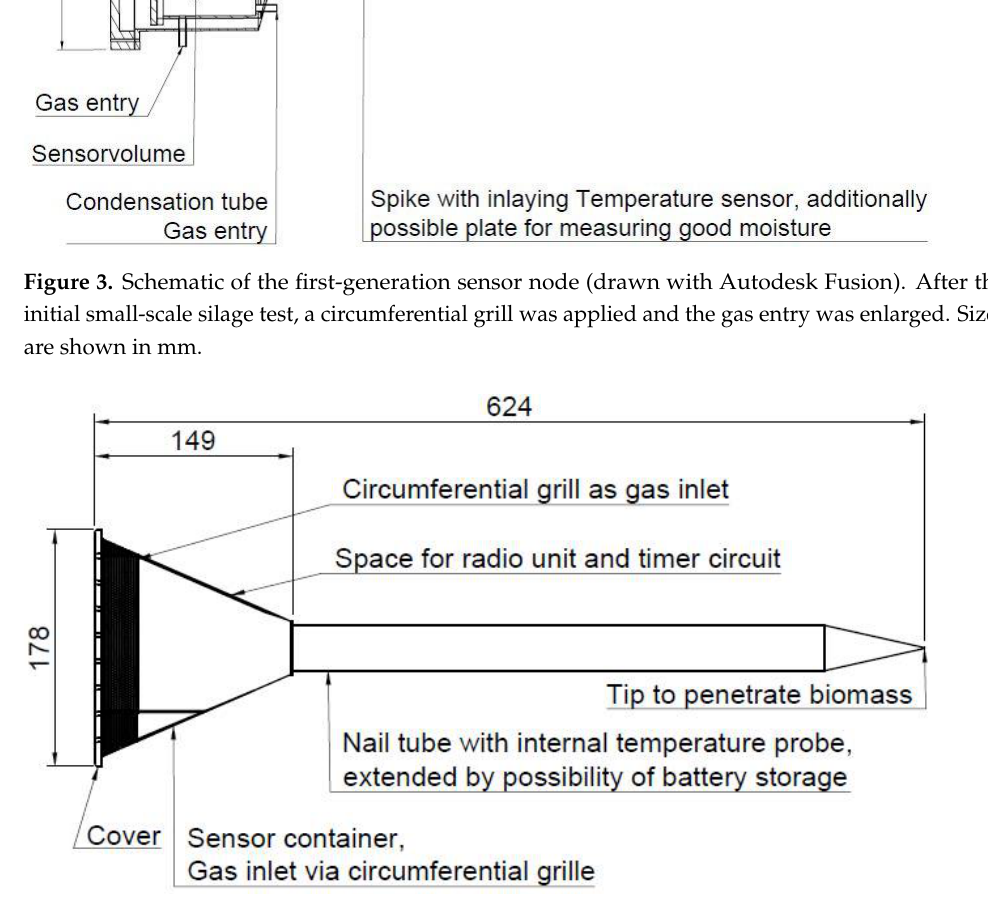
Figure 4. Schematic of the second-generation sensor node (drawn with Autodesk Fusion). The head is designed smaller, sensors come closer to the surface and an additional circumferential grill is applied to let gas enter the sensor container from all sides. The battery can now be positioned into the nail. Sizes are shown in mm.